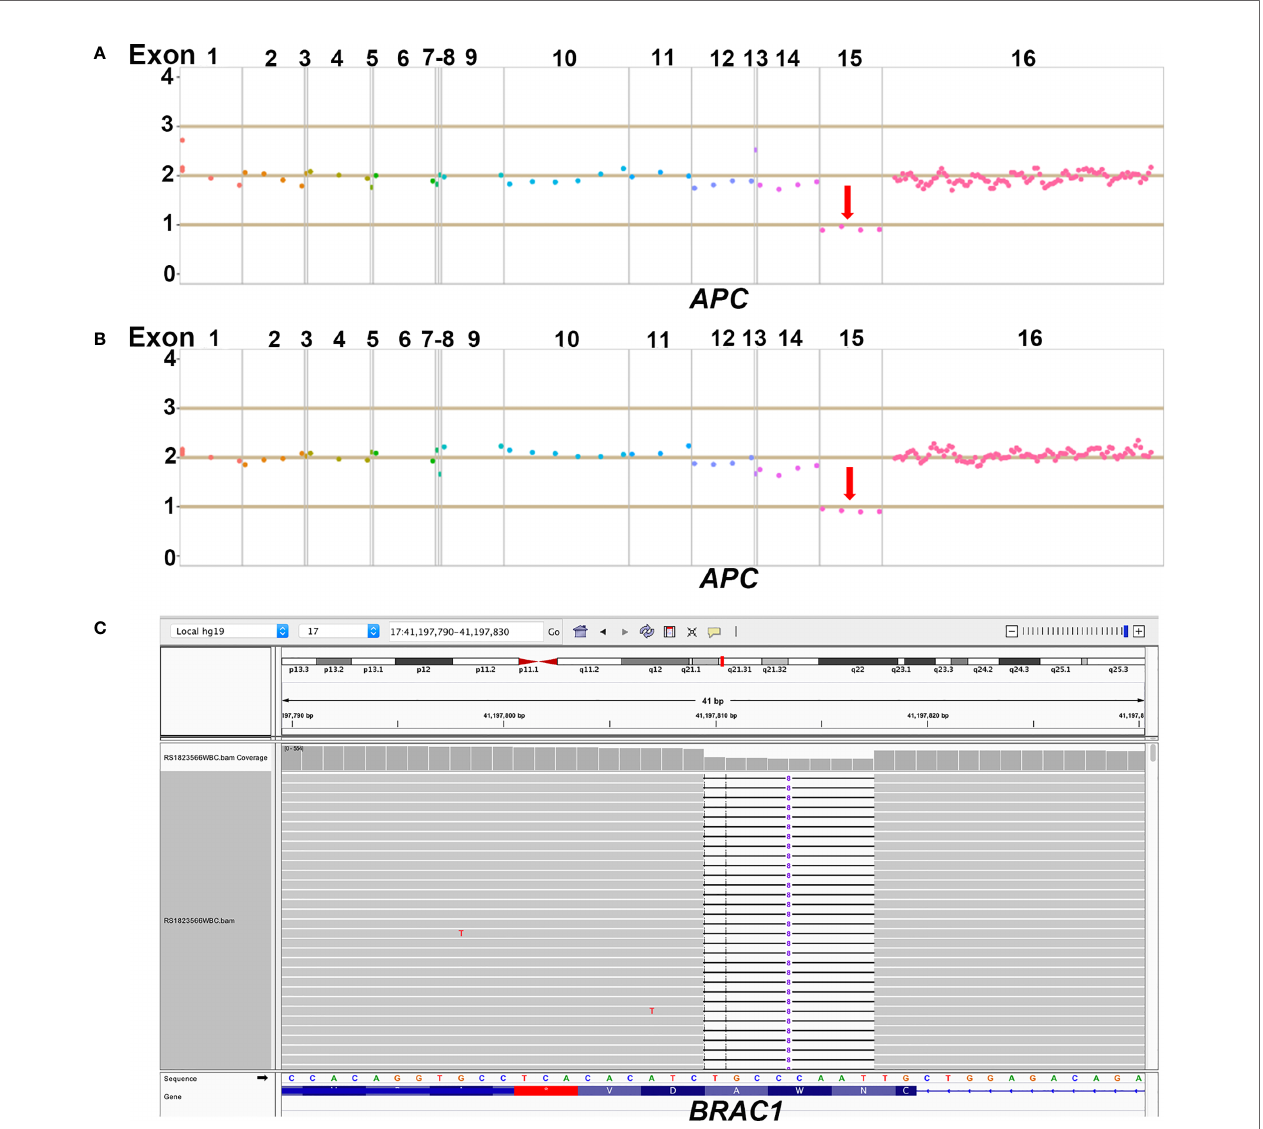
FIGURE 2 | Demonstration of NGS results of APC and BRCA1 germline mutations. (A) The heterozygous loss of exon 15 in APC gene was detected in the proband; (B) The same heterozygous loss of exon 15 in APC gene was also detected in the 20-year old male patient; (C) The heterozygous p.lle1824AspfsX3 in BRCA1 gene was detected in the 20-year old male